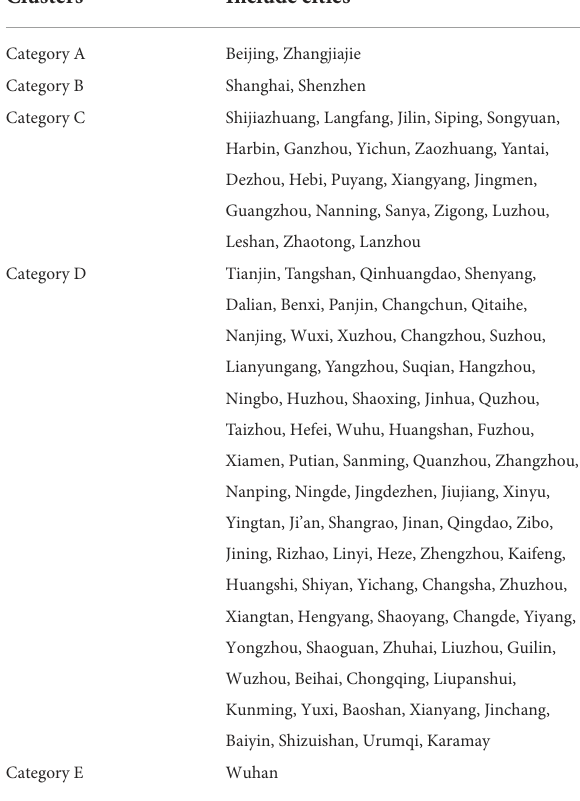
TABLE 6 City clustering